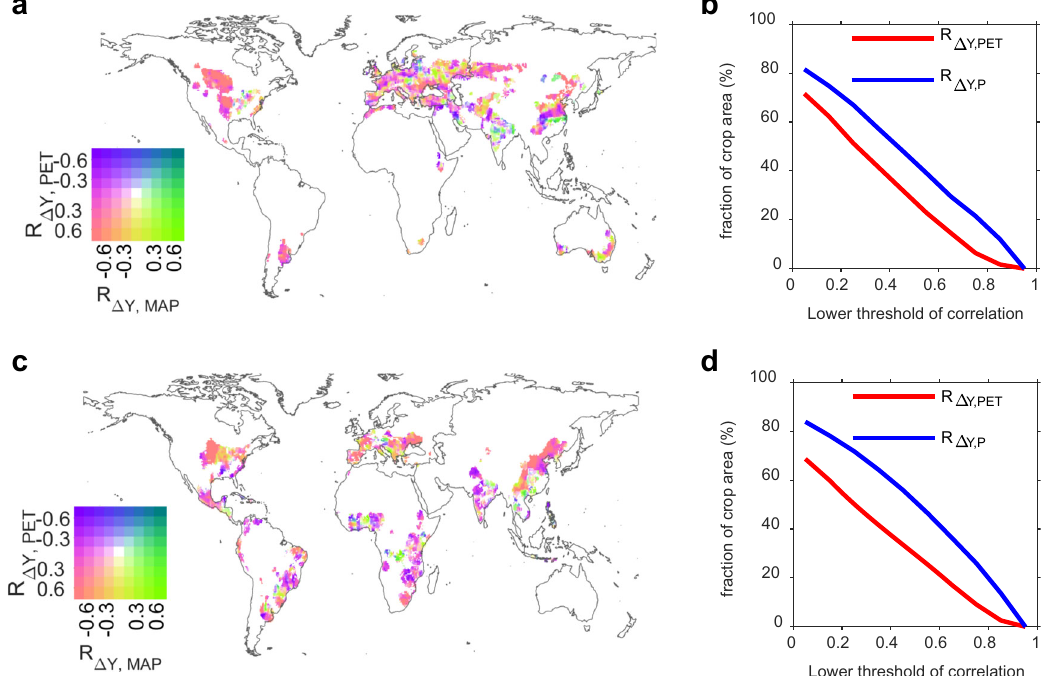
Fig. 3 Partial correlation in the spatial domain between reanalyzed Δ Y and climatic variables (potential evapotranspiration (PET) and mean annual precipitation (MAP)) for wheat (top panels) and for maize (bottom panels). a , c Bivariate mapping for spatial distribution of the partial correlation coef fi cient between Δ Y and PET ( R Δ Y,PET ) and that between Δ Y and MAP ( R Δ Y,MAP ). b , d Percentage of cropland area where Δ Y is controlled by PET or precipitation depending on the chosen threshold ( x -axis) for the partial correlation coef fi